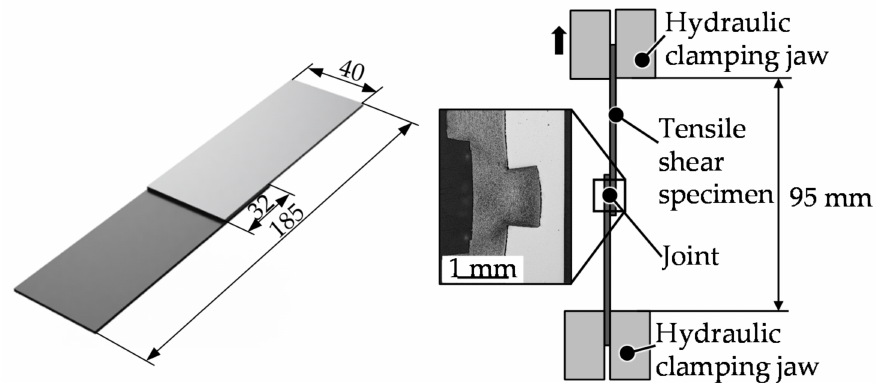
Figure 4. Schematic illustration of tensile shear specimen and test setup.